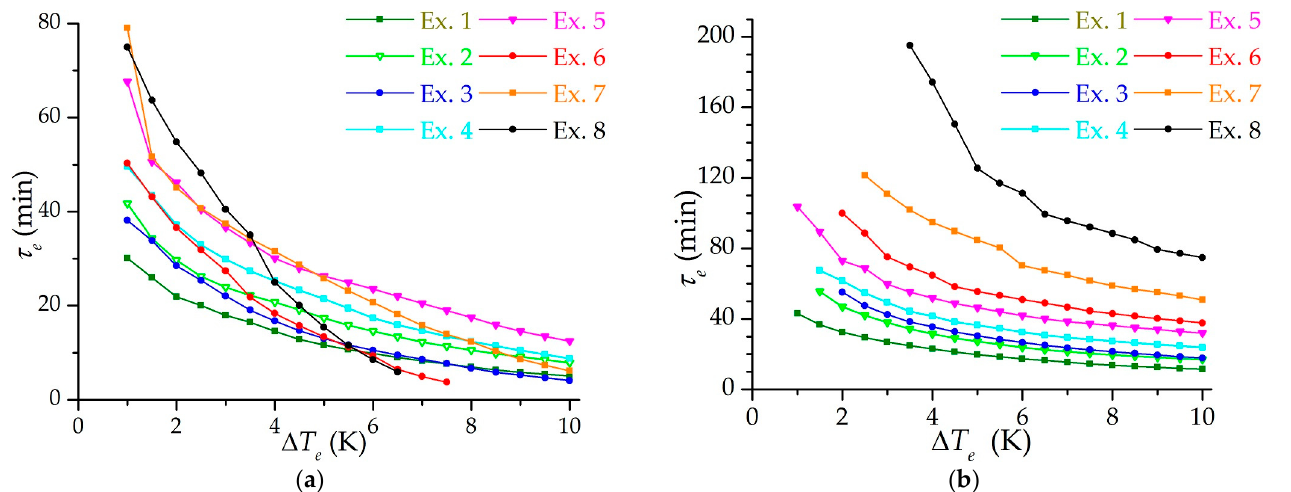
Figure 7. Dependence of the effective charging time on the final temperature difference between the inlet gas and the adsorbent for isothermal ( a ) and low-temperature charging ( b ) at different modes (the number of the experiment is indicated).